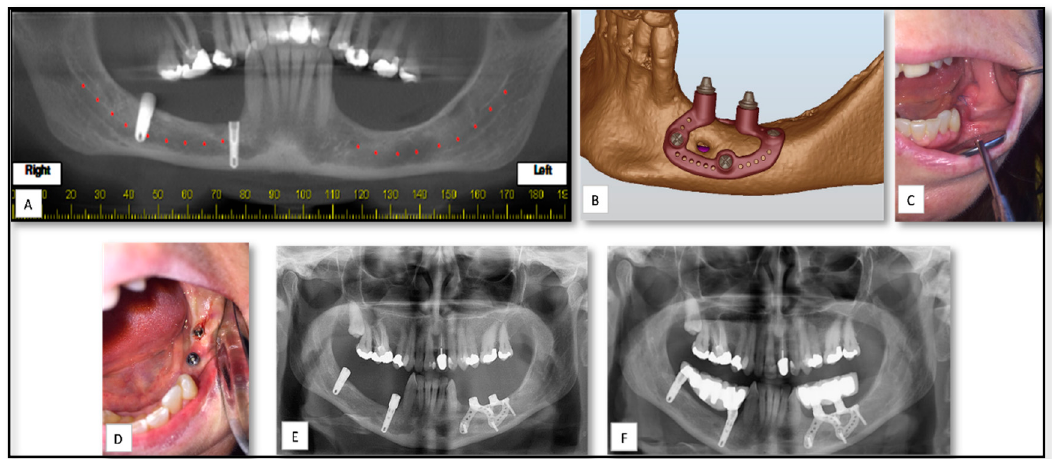
Figure 3. ( A ) Preoperative Cone beam computed tomography (CBCT) panoramic showed posterior edentulous mandible. ( B ) Pre-surgical planning and modeling of the sub-periosteal implant ( C ) One week after placement of the sub-periosteal implant shows proper healing. ( D ) One week after implant coverage and installation of dental healing caps. ( E ) and ( F ) Postoperative panoramic view showed the sub-periosteal implant with and without the final dental rehabilitation.